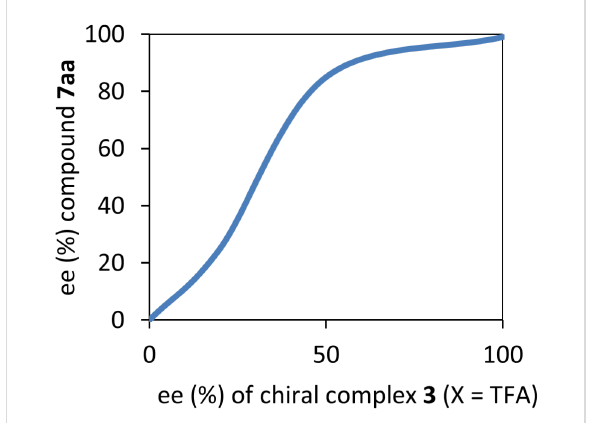
Figure 2: Positive non-linear effects (NLE) observed in 1,3-DC of azlactone 7aa and